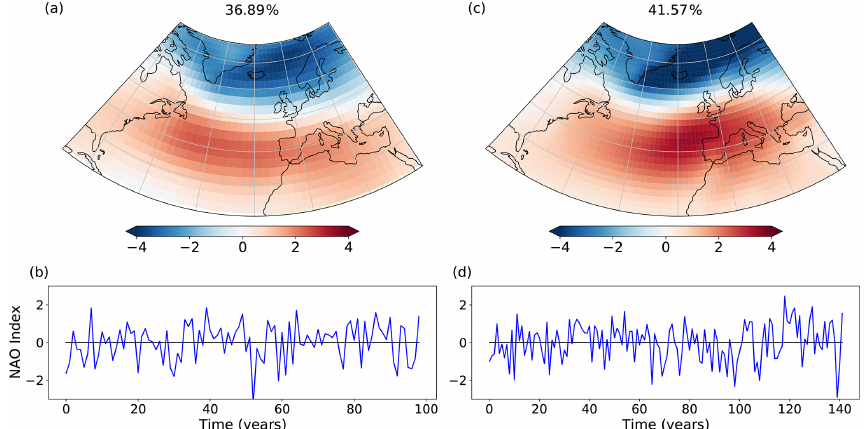
Figure 15. The NAO as represented by the first EOF and PC computed using deseasoned and latitude-weighted sea level pressure for FORTE 2.0 (a, b) and 20CR (c, d)